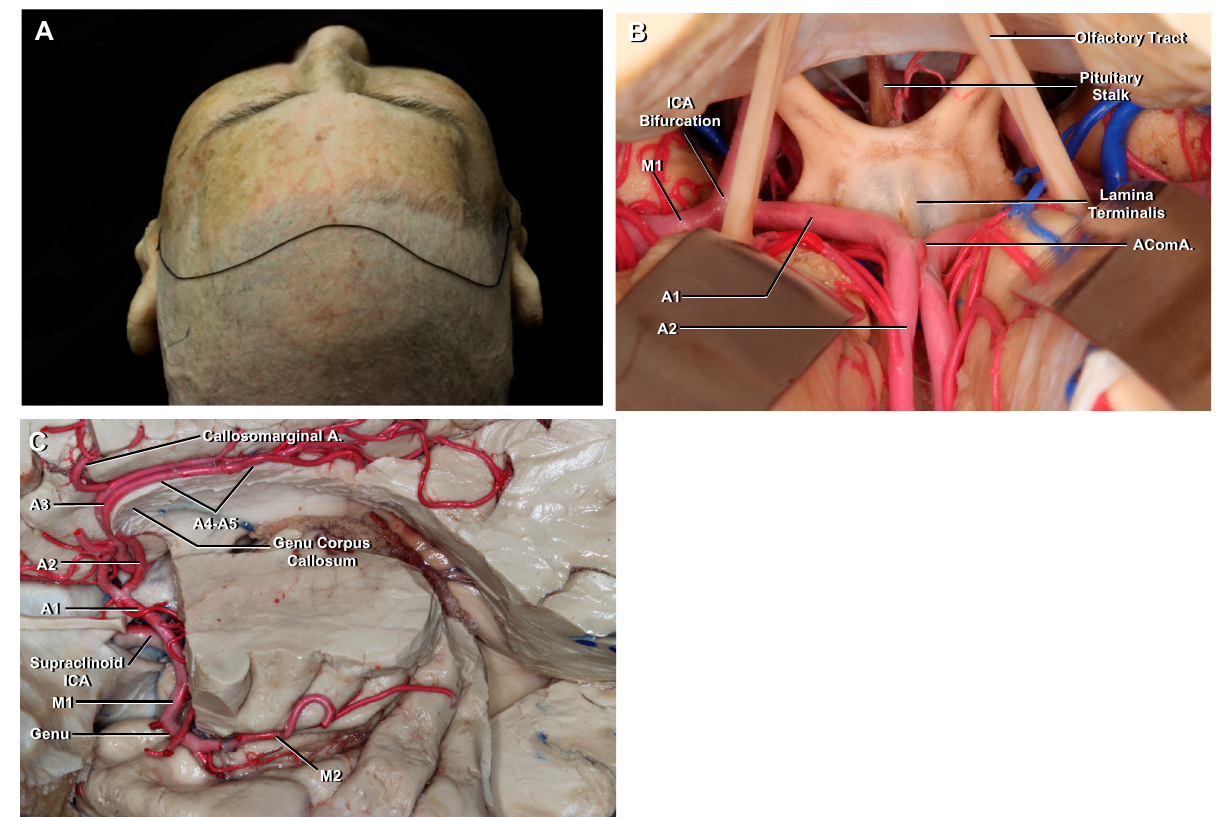
Figure 6. ( A ) Cerebrovascular anatomy as seen with a bicoronal and an interhemispheric approach to the region of the AComA. ( B ) The A1 originates from the ICA bifurcation and runs medially with a horizontal course above the optic chiasm, to join the AComA in the interhemispheric fissure. The A2 segment extends vertically from the AComA and follows the rostrum of the corpus callosum. ( C ) Another specimen. Superolateral view, left side. The different segments of the ACA are possible to identify, from the ICA bifurcation to its distal course in the pericallosal sulcus. The pericallosal artery is referred to as the ACA segment distal to the AComA that courses in the pericallosal sulcus. The callosomarginal artery courses in the cingulate sulcus.